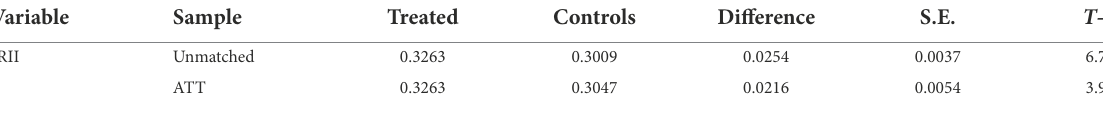
TABLE 6 Equity incentive (EI) and investor relations management (IRM): propensity score matching (PSM).